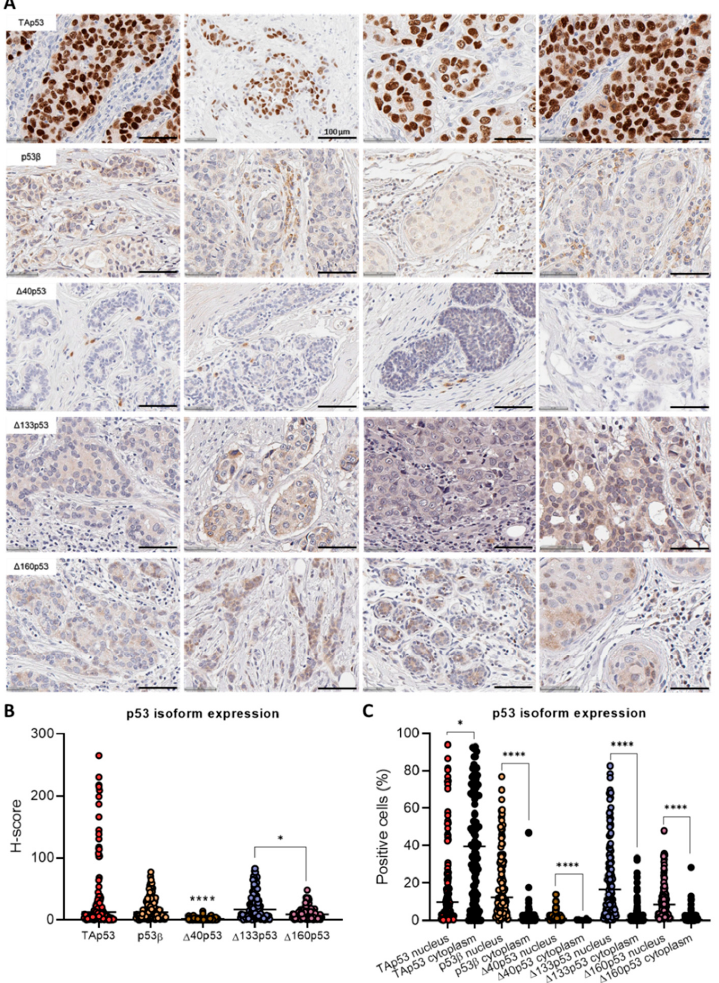
Figure 2. Immunohistochemistry analysis of p53 and its isoforms in 108 invasive breast cancer spec- imens. ( A ) Representative images of slides stained for TAp53 (DO-1), p53 β (KJC8), Δ 40p53 (KJC40),